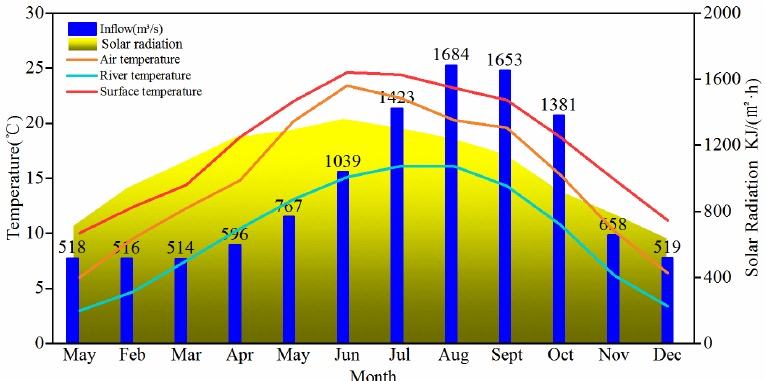
Figure 3. Duration curves of meteorological and hydrological data.